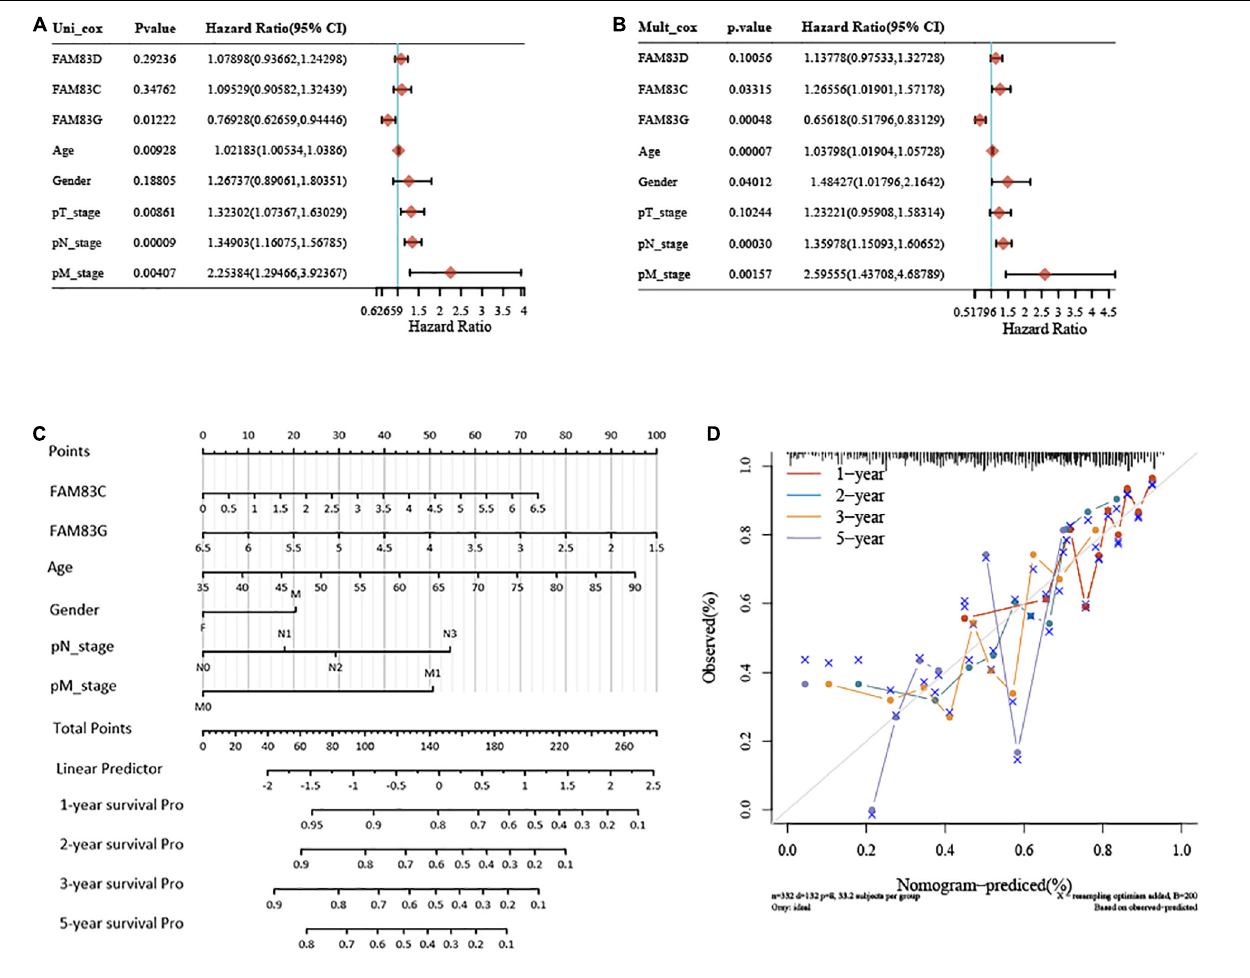
FIGURE 10 | Univariate and multivariate Cox regression analyses and establishment and verification of Nomogram for the FAM83 family genes and clinical risk factors of STAD patients. (A,B) Forest plots for hazard ratios (HRs) of survival-associated FAM83 family genes and clinical risk factors in STAD. (C) Nomogram to predict the 1-, 2-, 3-, and 5-year overall survival of STAD patients. (D) Calibration curve for the overall survival nomogram model in the discovery group. A dashed diagonal line represents the ideal nomogram, and the brown line, blue line, orange line and purple line represent the 1-, 2-, 3-, and 5-year observed nomograms,